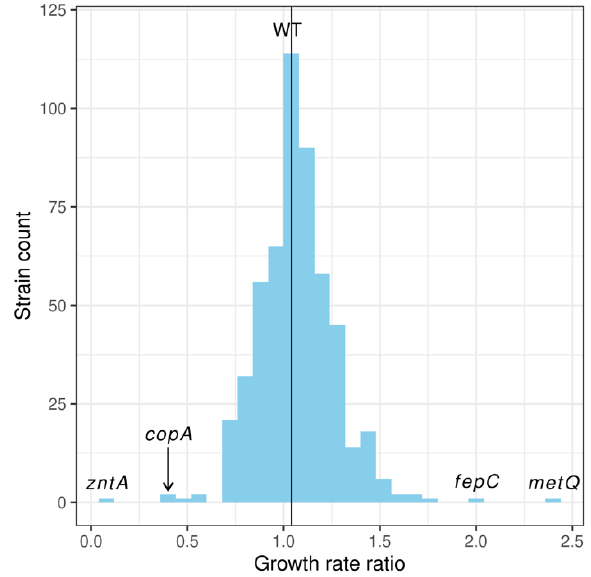
Figure 1. Distribution of bacterial growth in the presence of 2 µM pyrithione . The Keio collection subset (532 knockout strains for gene encoding membrane proteins) was exposed to pyrithione and their growth compared against the unexposed samples and these ratios are represented in the abscissa. The reference strain (WT) with a mean ratio of 1.04 occupies the bin that contains the highest count of strains. The following four boundary knockout strains selected here are further denoted by the location of their growth rate ratios of exposed over unexposed: zntA , copA, fepC , and metQ .